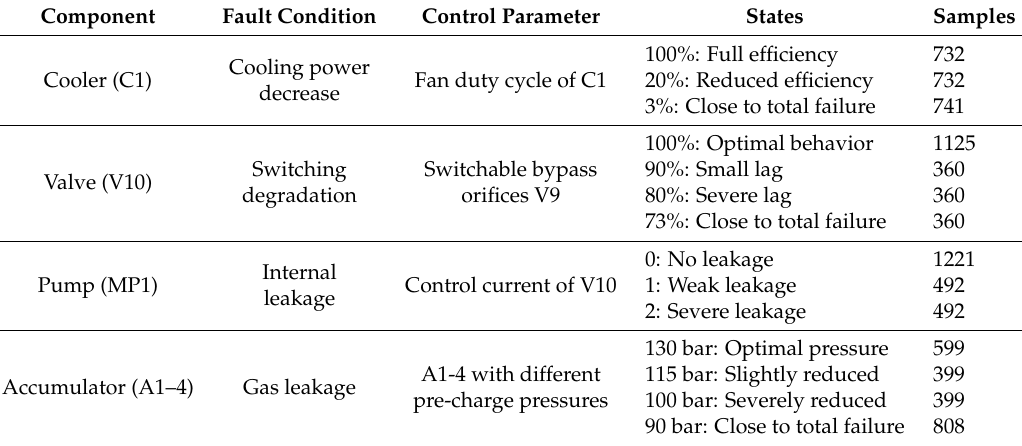
Table 2. Hydraulic fault component